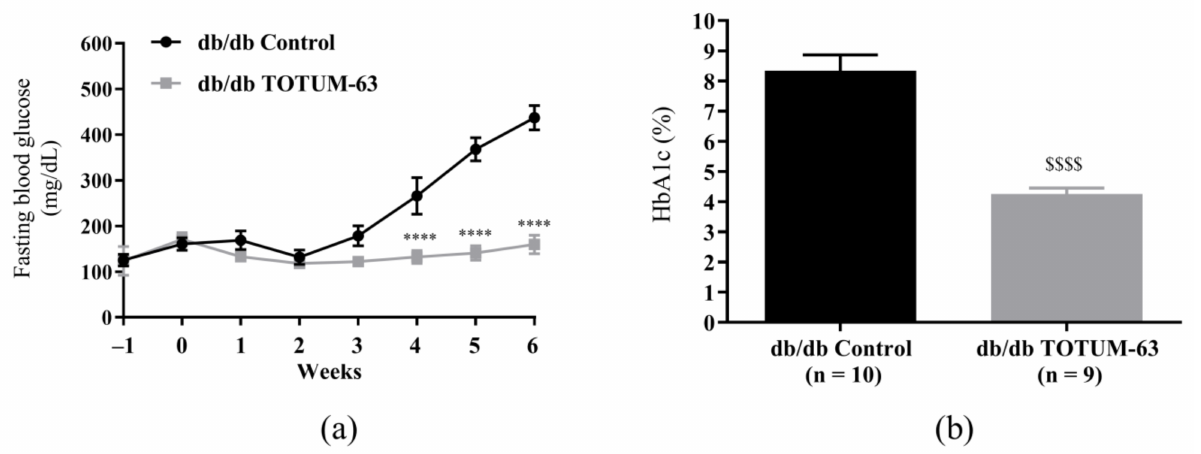
Figure 6. Evolution of fasting blood glucose levels ( a ) and HbA1c levels at week 6 ( b ) in db/db mice. **** p < 0.0001 (two-way ANOVA followed by the Sidak multiple comparisons test). $$$$ p < 0.0001 (Welch corrected unpaired t -test). Values are the mean ± SEM. n = 9 or 10 for all measurements. db/db, leptin receptor-deficient mice; HbA1c, glycated